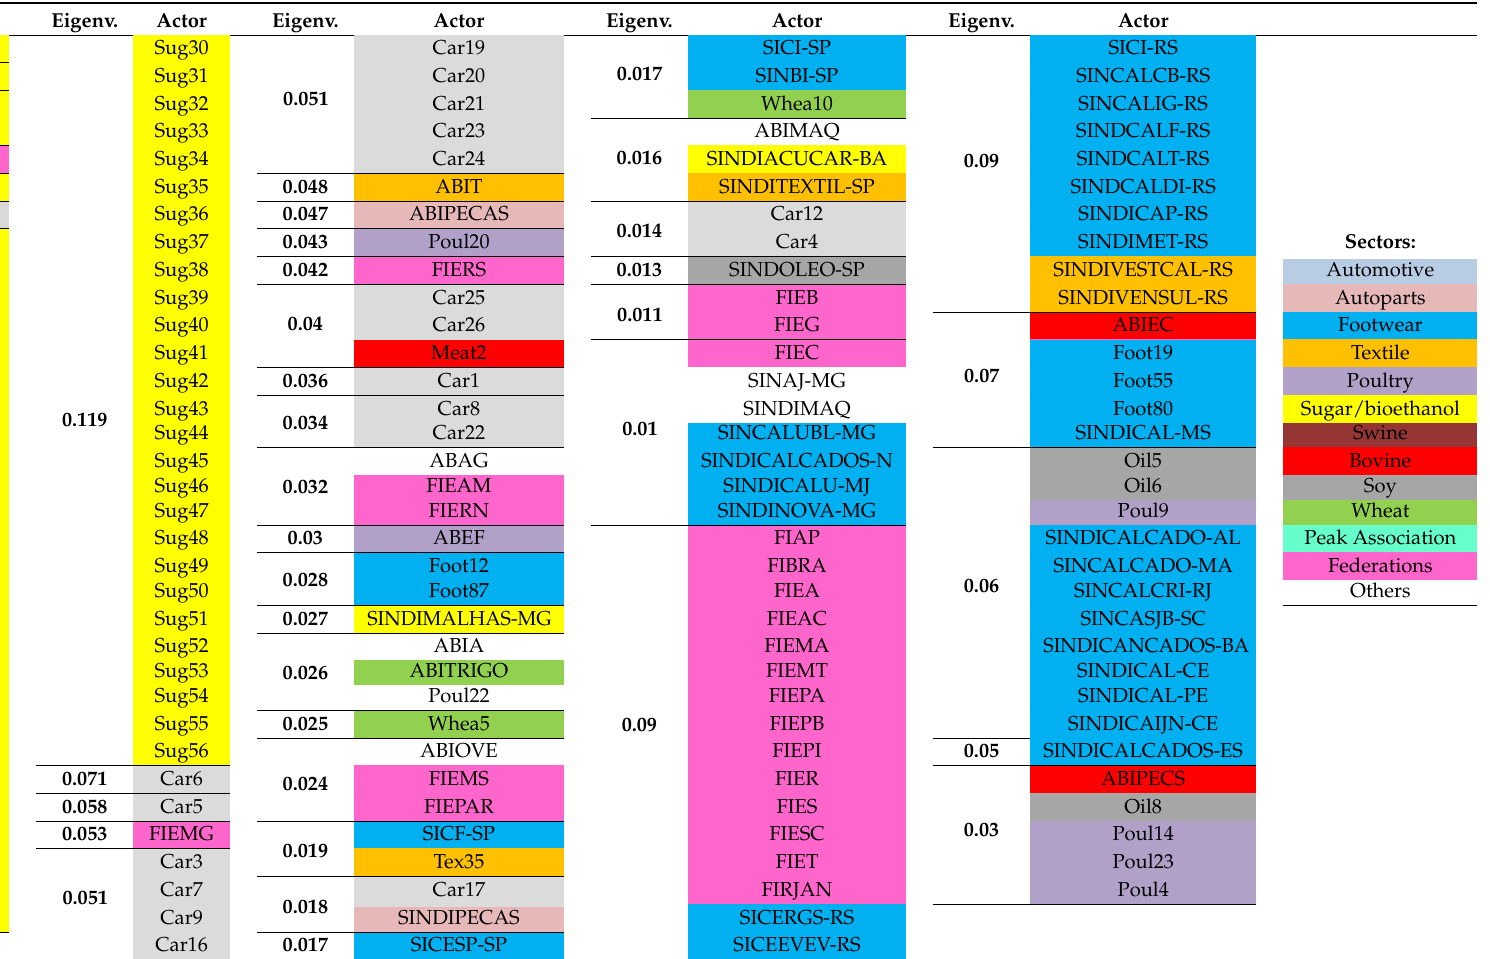
Table A4. Eigenvector centrality measures by